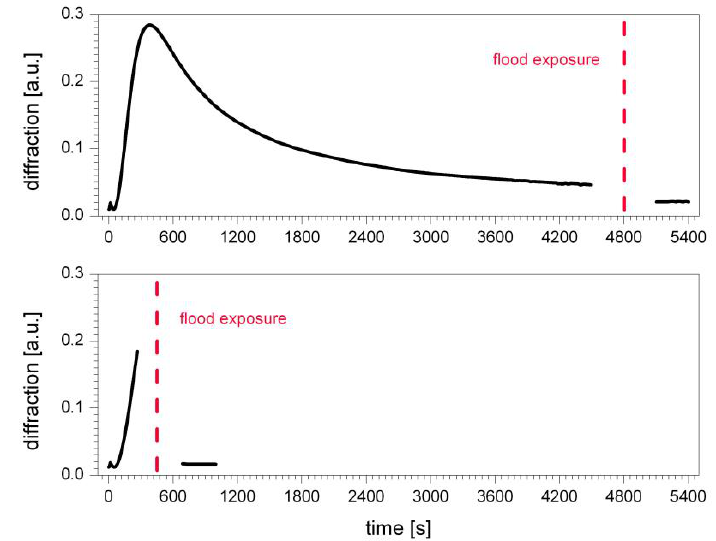
Figure 6. Impact of UV flood exposure on volume holographic grating growth in SU-8.: flood exposure results in an abrupt stop of the grating growth and erasure of the hologram, regardless of the implementation time. Fixation is performed during saturation state ( top ) and during maximum diffraction ( bottom ). In both cases the flood exposure results in destruction of the grating.